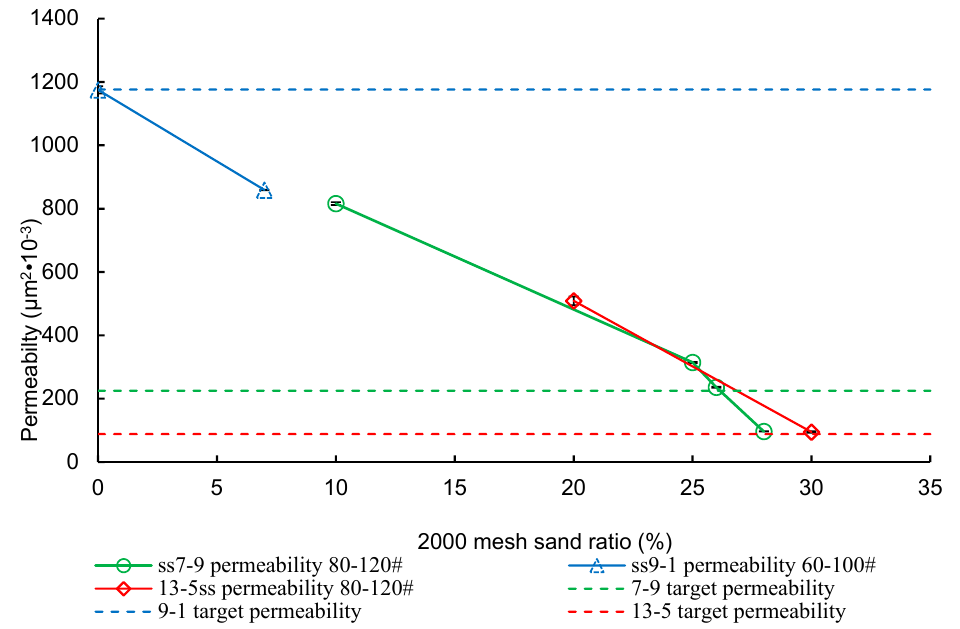
Figure 11. Permeability vs. 2000 mesh sand ratio for fine adjustment of cementation in synthetic sandstone samples.